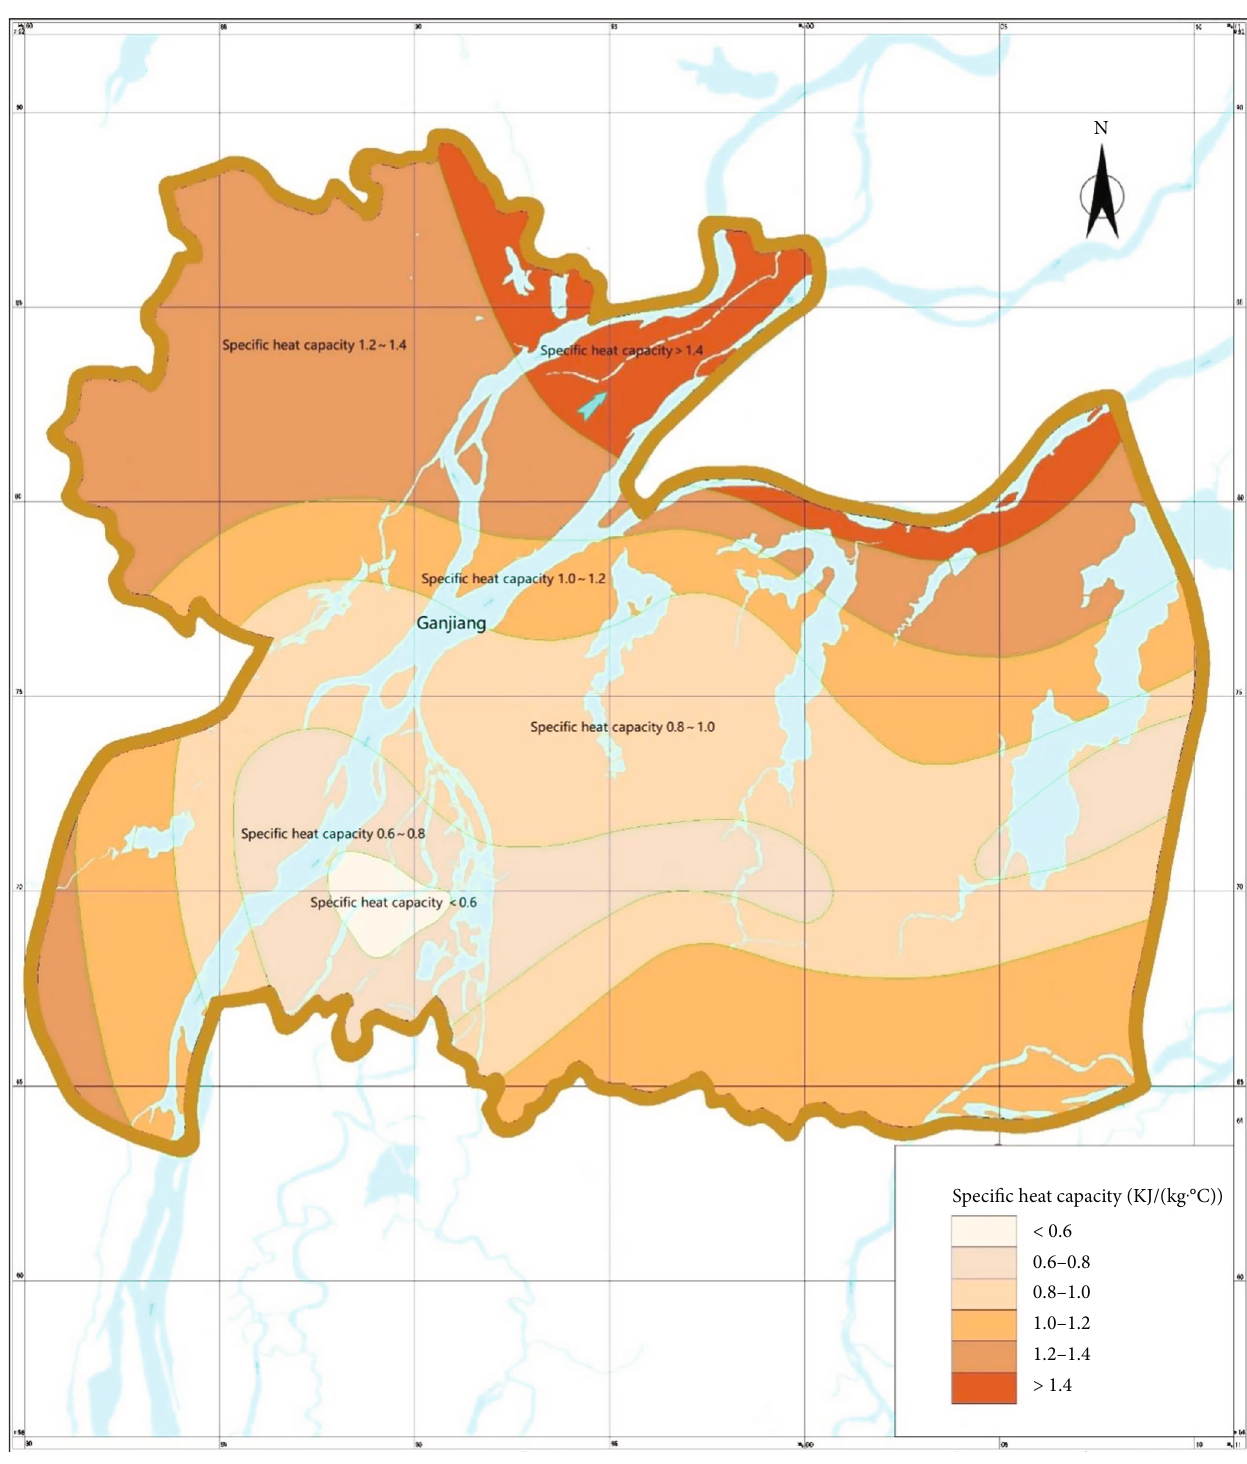
Figure 5: Plan distribution of speci fi c heat capacity of rock and soil